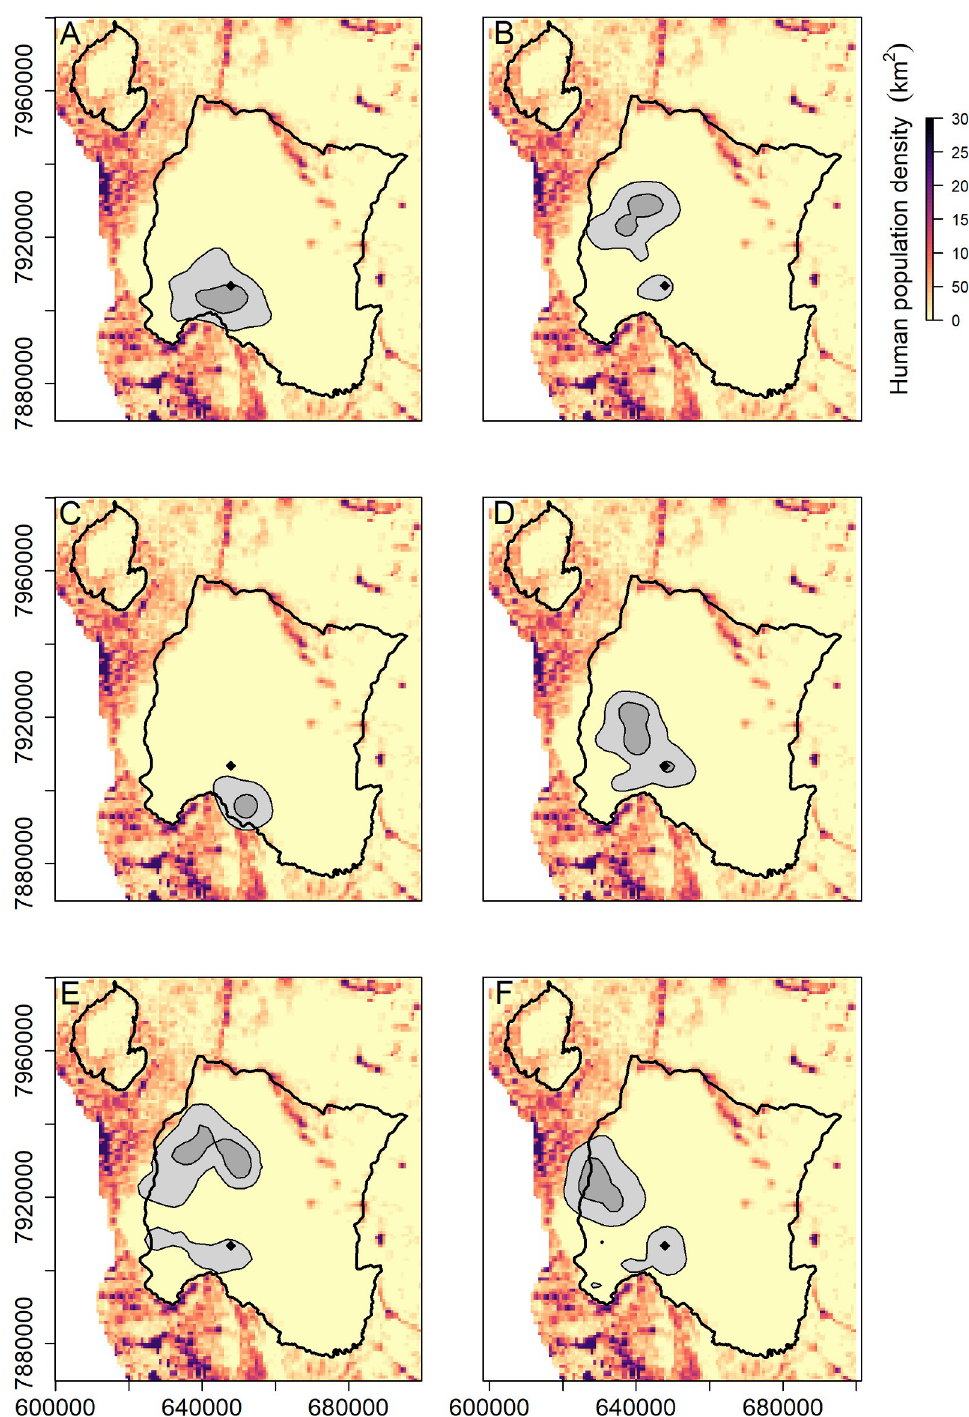
Fig 5. The 95% total territory area (light grey) and the 50% core territory area (dark grey) for wild dogs in Gorongosa National Park (solid black line) between June 2018 and September 2020 overlaid on the human population density raster for the Gorongosa-Marromeu landscape. Panels represent different groups of wild dogs: (A) Gorongosa pack, (B) Pwadzi pack, (C) Cheza pack, (D) Mopane pack, (E) Mucodza dispersal group and (F) Xivulo dispersal group. The diamond symbol represents the enclosure release site for the two founder packs (Gorongosa and Pwadzi